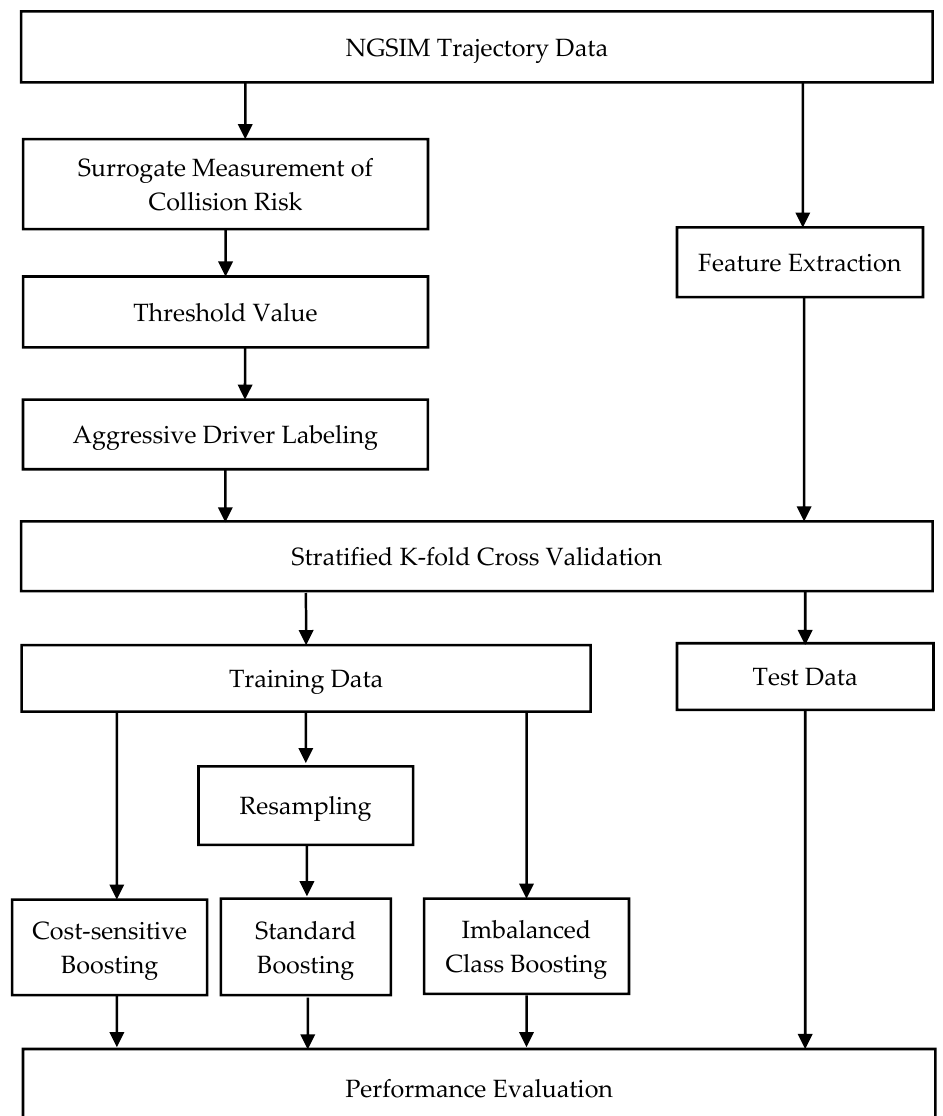
Figure 1. Methodology framework.